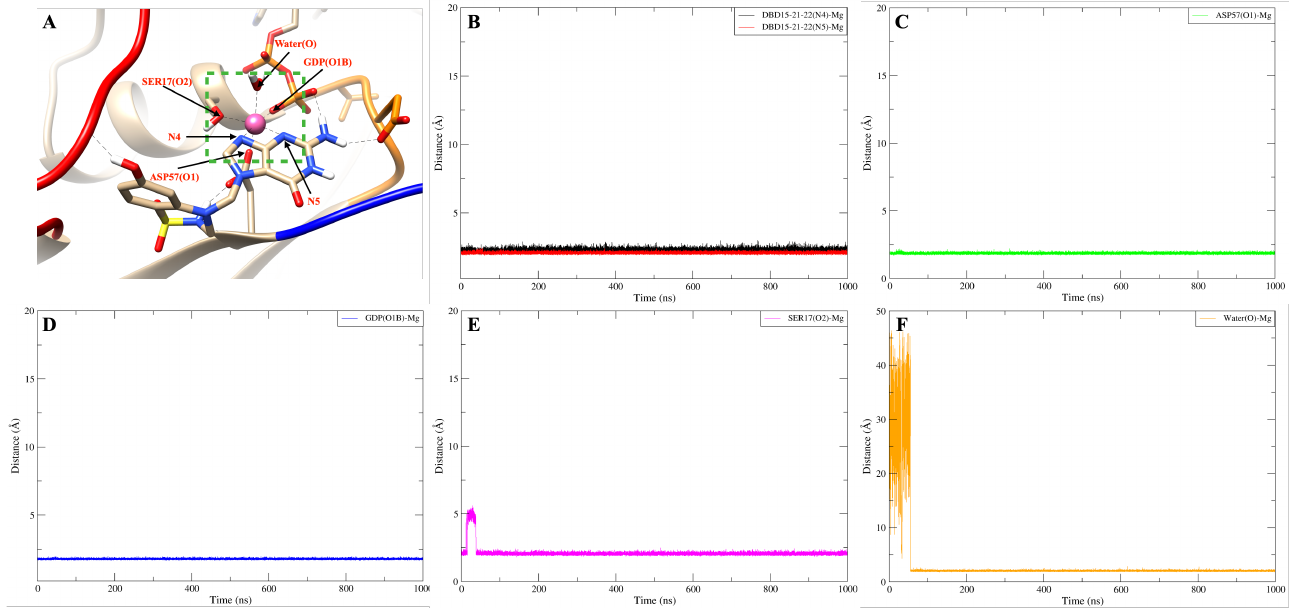
Figure A17. DBD15-21-22 binding on the dynamic water pocket I and stabilized the octahedral structure of Mg 2 + . ( A ) Representative snapshot of DBD15-21-22 (N4,N5) form coordination bond with Mg 2 + ; ( B ) distance between DBD15-21-22 (N4,N5) and Mg 2 + ; ( C ) distance between ASP57 (O1) and Mg 2 + ; ( D ) distance between GDP (O1B) and Mg 2 + ; ( E ) distance between SER17(O2) and Mg 2 + ; ( F ) distance between water molecular in position H 2 O-1 and Mg 2 +